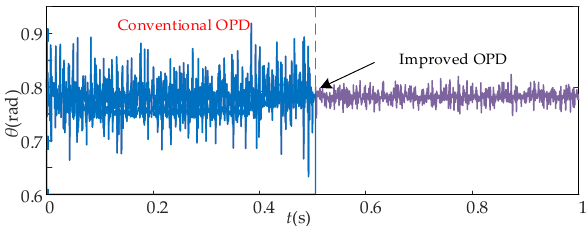
Figure 15. Initial phase simulation results when adopting the improved algorithm.